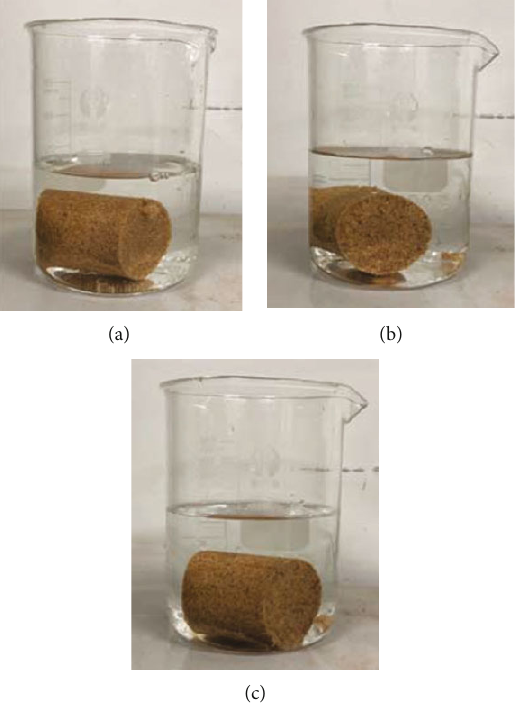
Figure 8: The state of the specimens with di ff erent PU content after oscillating: (a) 1.40g/cm 3 ; (b) 1.50g/cm 3 ; (c) 1.60g/cm 3 .